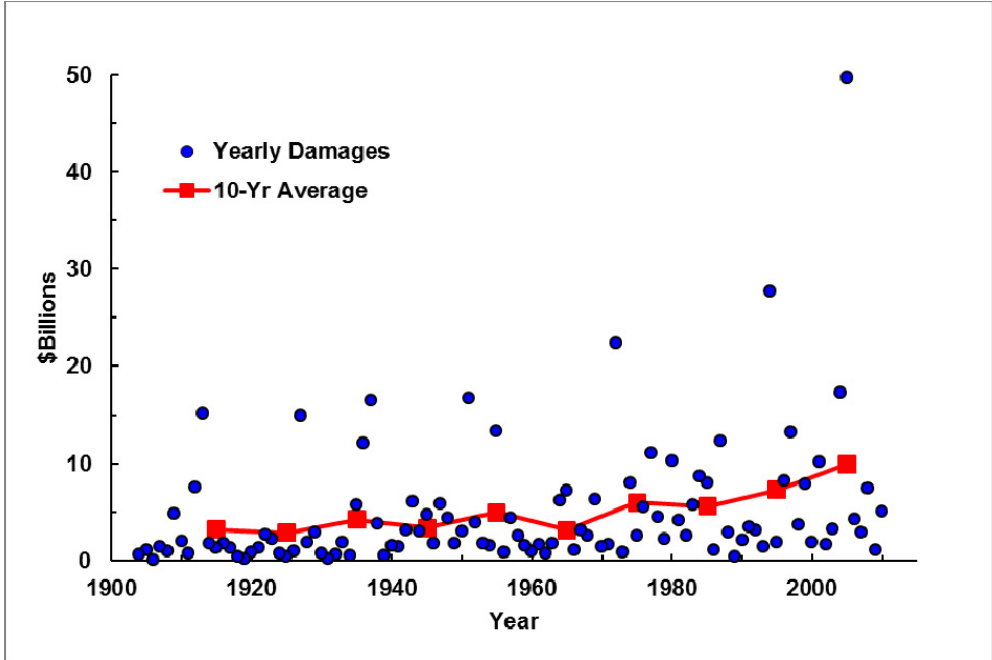
Figure 1. Inflation-adjusted yearly estimates of flood damage in the US